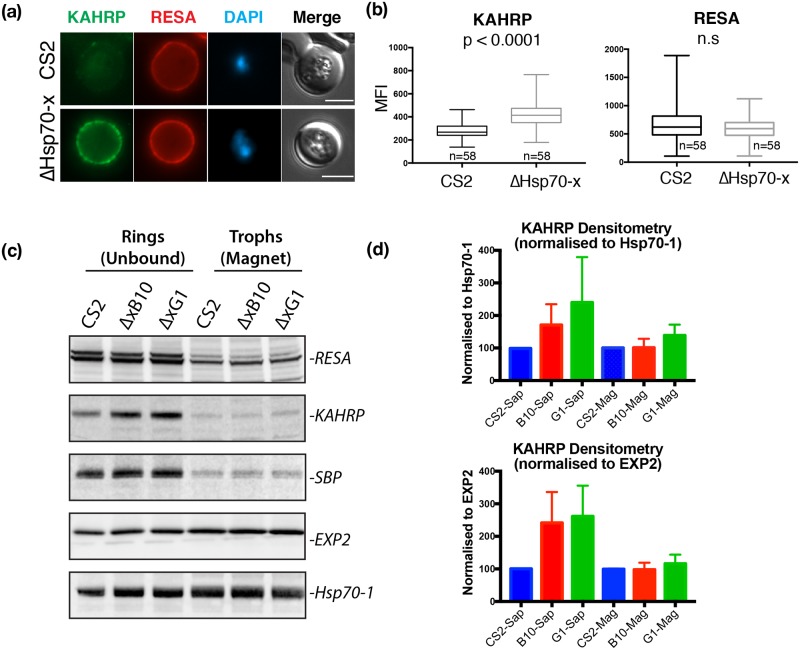
The expression of cytoskeletal binding proteins KAHRP is increased in ΔHsp70-x.(a) Immuno fluorescence microscopy of 16-24hpi parasites indicates expression of the exported, knob localized KAHRP protein but not RESA appears higher in ΔHsp70-x. n = number of cells counted. (b) Mean fluorescence intensity (MFI) measurements of the erythrocyte compartment confirmed the KAHRP signal is higher in ΔHsp70-x compared to CS2 (Mann Whitney test). (c) Western blot analysis of magnet binding (trophozoites) and unbound (ring stage) parasites indicates KAHRP but not RESA or SBP1 appears to be more highly expressed in two ΔHsp70-x clonal lines. Whole purified trophozoites and saponin treated ring stage parasites were analyzed. (d) Densitometry of KAHRP levels from three blots normalized to Hsp70-1 and EXP2 loading controls, indicated that although KAHRP expression was always higher in ΔHsp70-x than CS2 this was not significant (p = 0.1, pairwise comparison, Mann Whitney test).